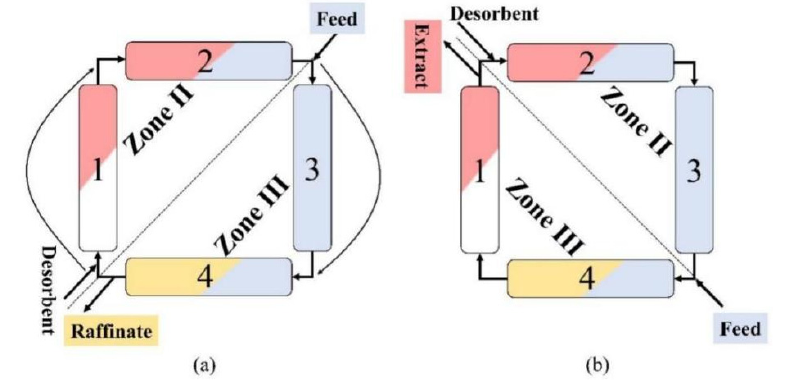
Figure 5. Schematic diagram of Two-zone SMB: ( a ) The end of the previous switch. ( b ) The beginning of the next switch.